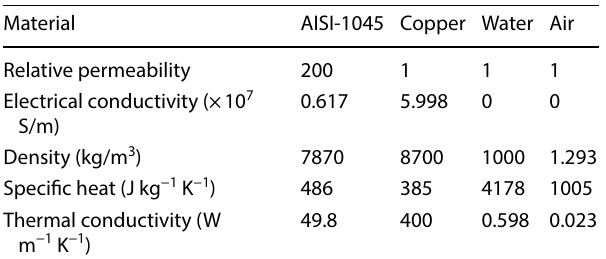
Table 1 Electromagnetic and thermophysical properties of related materials [24]